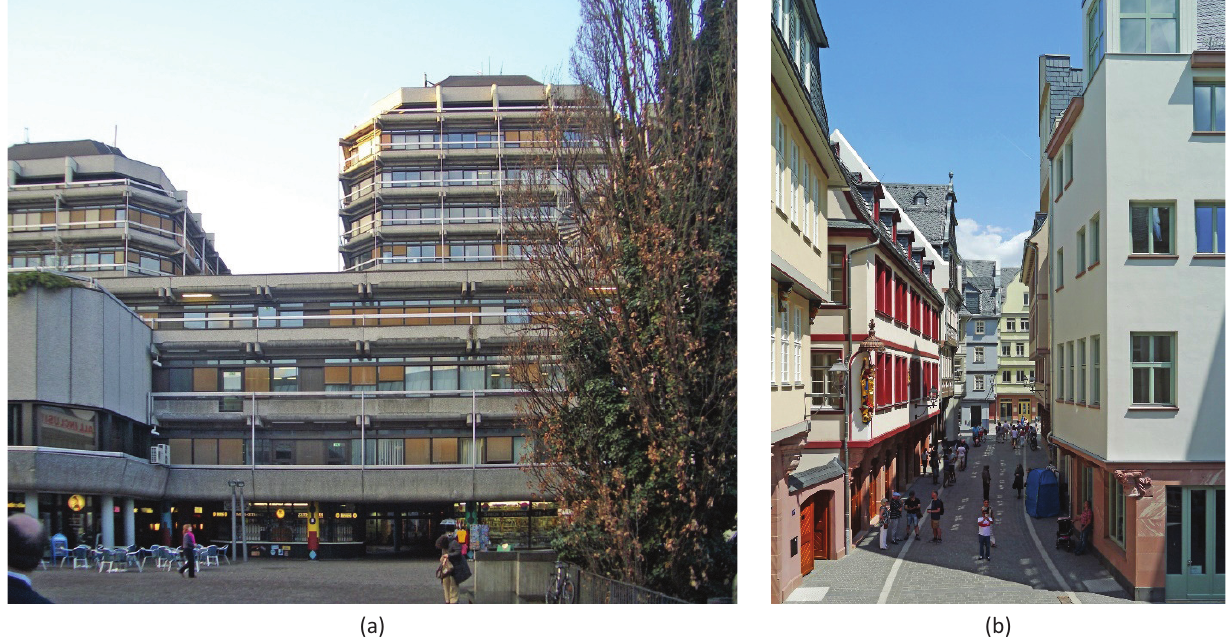
Figure 5. Technical City Hall (a) and part of the reconstructed old town (b). Sources: (a) König (2008) and Simsalabimbam